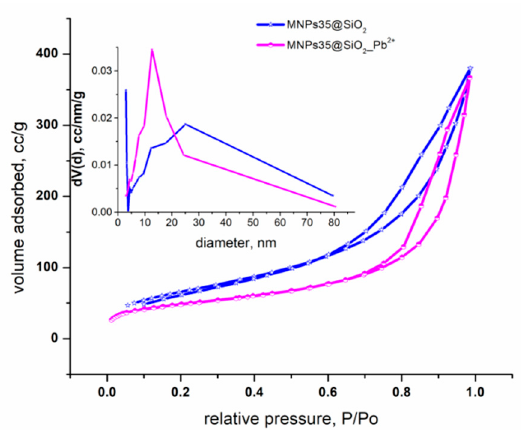
Figure 6. N 2 adsorption-desorption isotherms of the magnetic nanocomposite MNPs35@SiO 2 before and after Pb 2 + ions adsorption